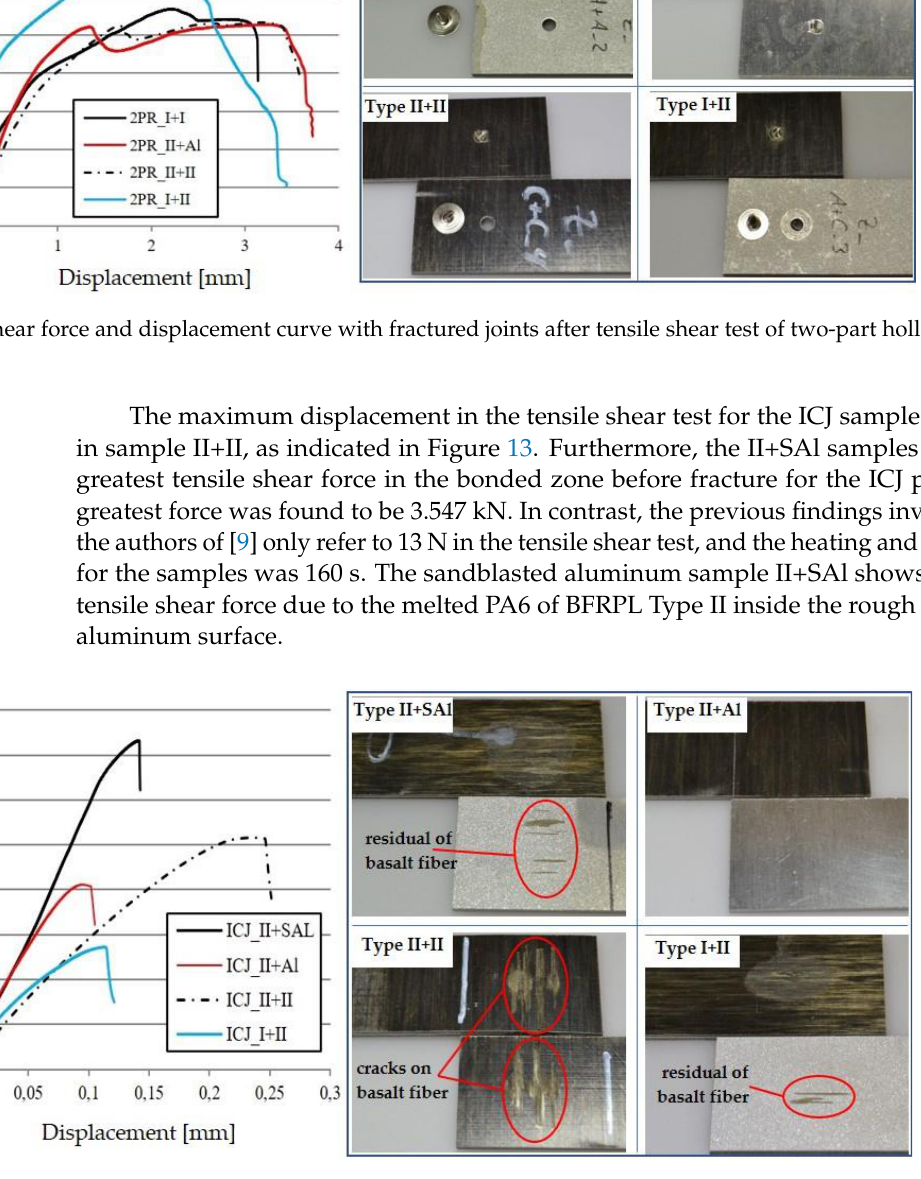
Figure 13. Tensile shear force and displacement curve with fractured joints after the tensile shear test of the ICJ process samples.